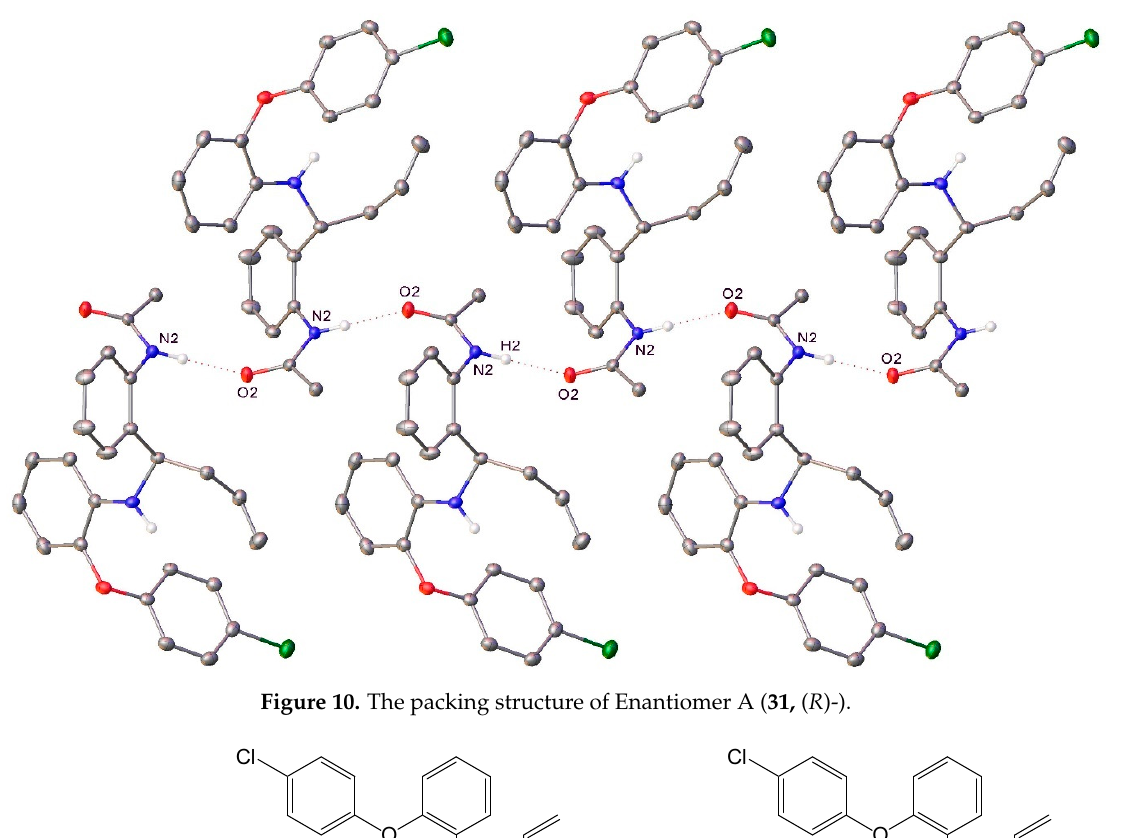
Figure 10. The packing structure of Enantiomer A ( 31, ( R )-).